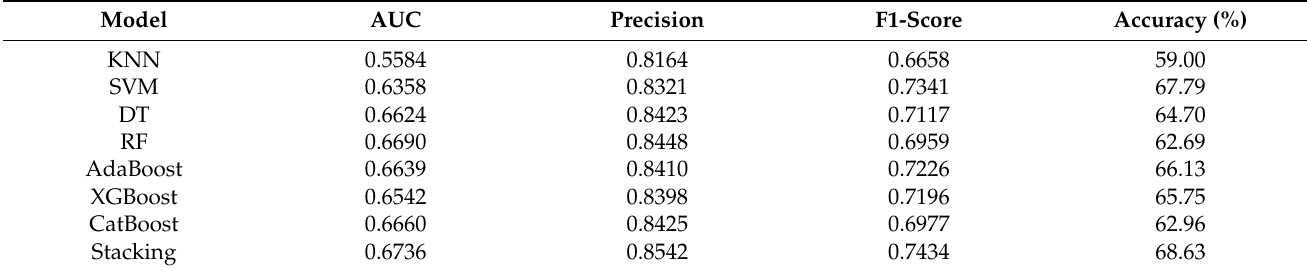
Table 3. Performance metrics of models for